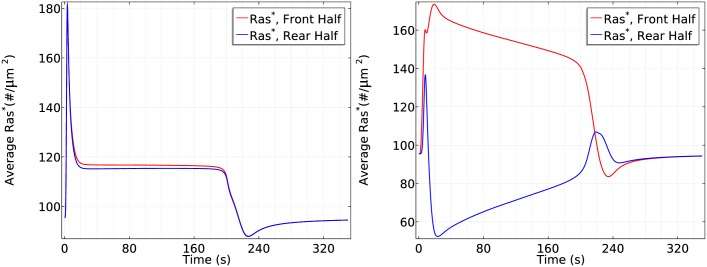
The time course of Ras activation at the front and rear halves for a wave speed v = 50μm/s (left), and v = 0.5μm/s (right).